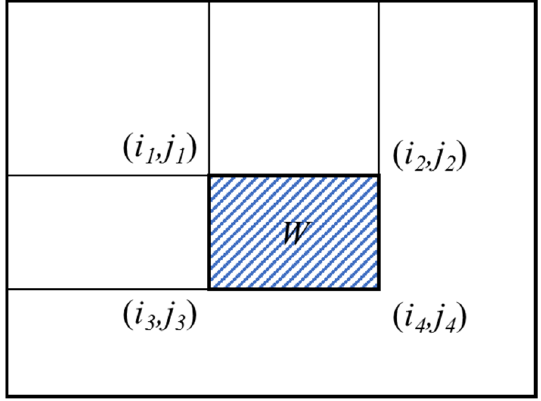
Figure 11. Concept of integral